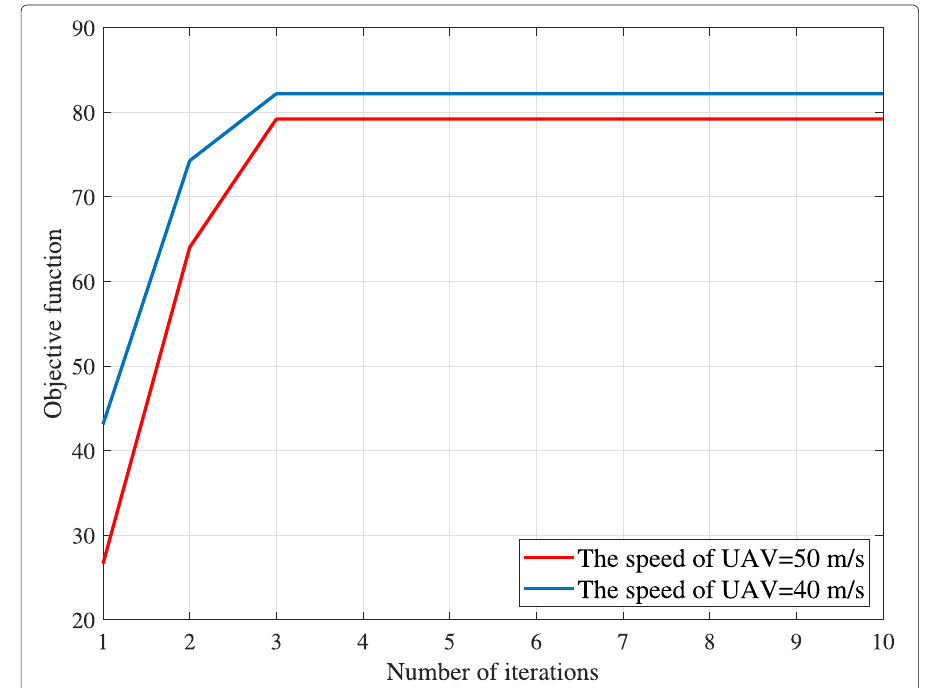
Fig. 3 BS-VS association performance with given power versus different flight speeds of UAV